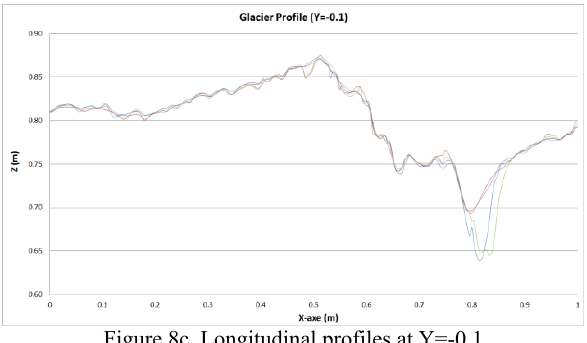
Figure 8c. Longitudinal profiles at Y=-0.1